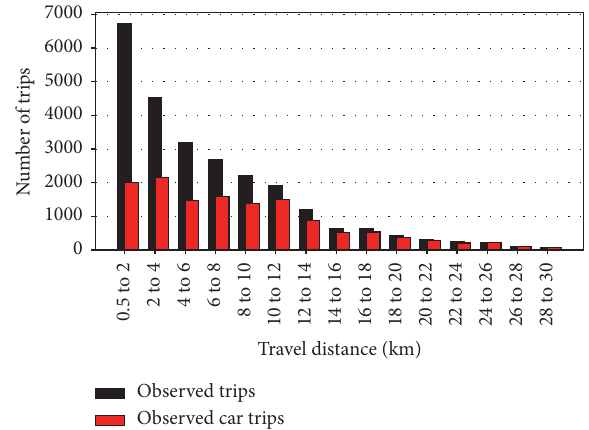
Figure 4: All observed trips vs. observed car trips, grouped by departure time during 24 hours.